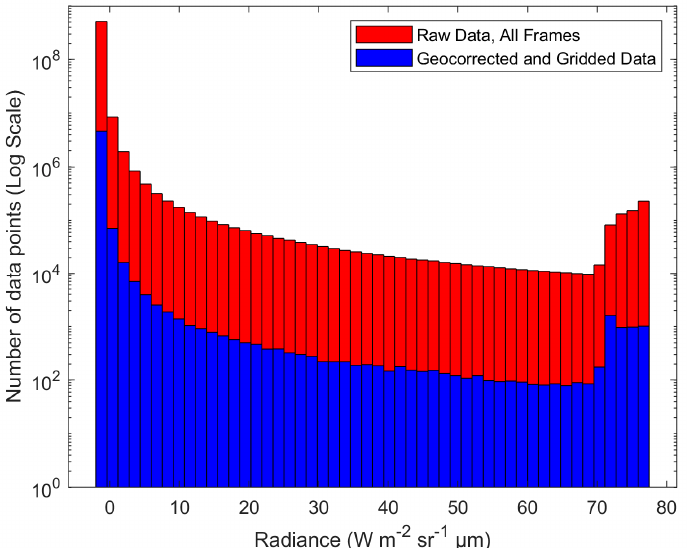
Figure 9. A histogram of the FLIR data in Radiance (Wm − 2 sr − 1 µm − 1 ). The distribution of count values remains very similar through the geocorrection process, even though the amount of data has been greatly reduced. Table 3. Statistics of all frames of raw data, and the geocorrected, gridded data. Despite the reduction of data points to arrive at the gridded dataset, the data has not been greatly altered, indicated by the similar statistics of the two datasets. Note that all values, other than the total number of data